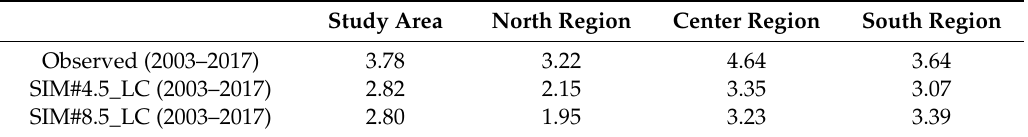
Figure 15. Estimates of mean annual soil erosion rates based on observations (left); and using erosion scenarios SIM#4.5_LC (center) and SIM#8.5_LC (right) with time-dependent land cover (DUSAF 2000 from 2003 to 2010 and LC 2030 from 2011 to 2017). Table 8. Mean observed and simulated annual erosion rates [t ha − 1 yr − 1 ] with two climate scenarios and time-dependent land cover (DUSAF 2000 from 2003 to 2010 and LC 2030 from 2011 to 2017). Study Area North Region Center Region South